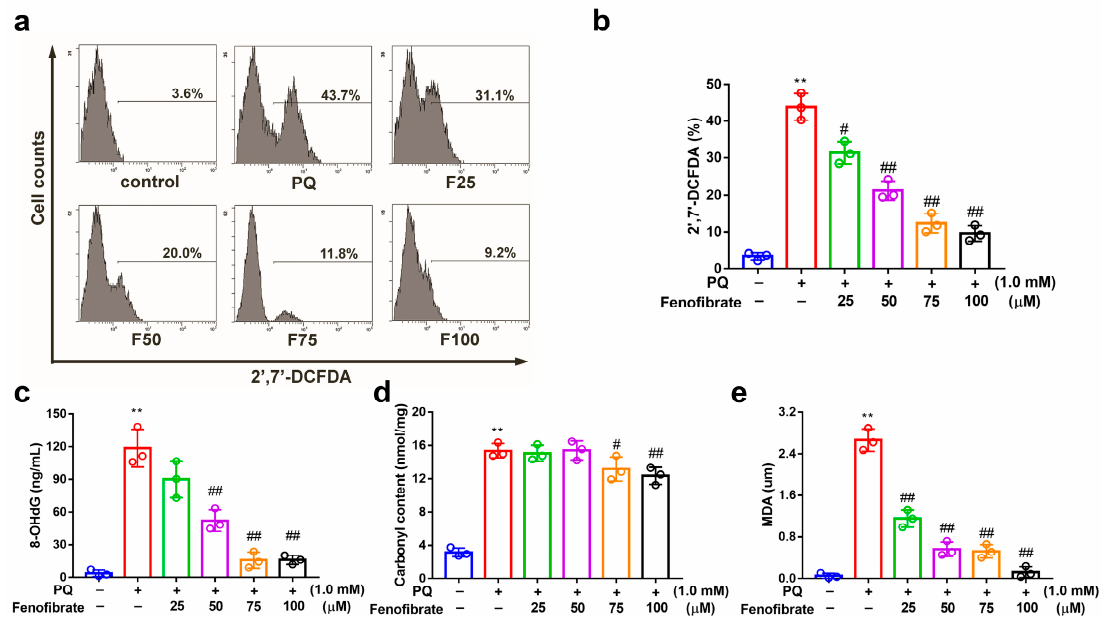
Figure 3. Effects of fenofibrate on reactive oxygen species (ROS) production and oxidative stress indicators in paraquat (PQ)-stimulated RF/6A cells assessed by flow cytometry. RF/6A cells were pretreated with different concentration of fenofibrate for 1 h, then exposed to 1 mM PQ for 24 h. ( a ) PQ-induced ROS production under fenofibrate treatment. The x -axis represents 2 ′ ,7 ′ - dichlorodihydrofluorescein diacetate (2 ′ ,7 ′ -DCFDA) staining, and the Y -axis represents cell numbers. PQ: 1 mM PQ; F25: 1 mM PQ with 25 μ M fenofibrate; F50: 1 mM PQ with 50 μ M fenofibrate; F75: